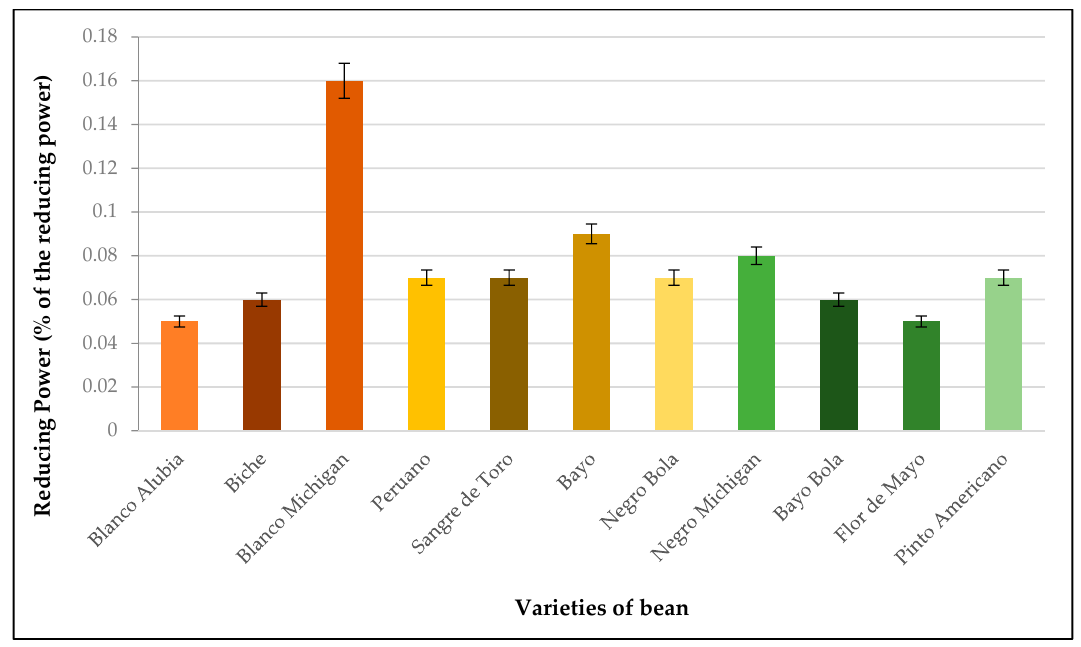
Figure 2. Reducing power in bean varieties produced in the State of Oaxaca. Data are means ± standard error ( n = 3).